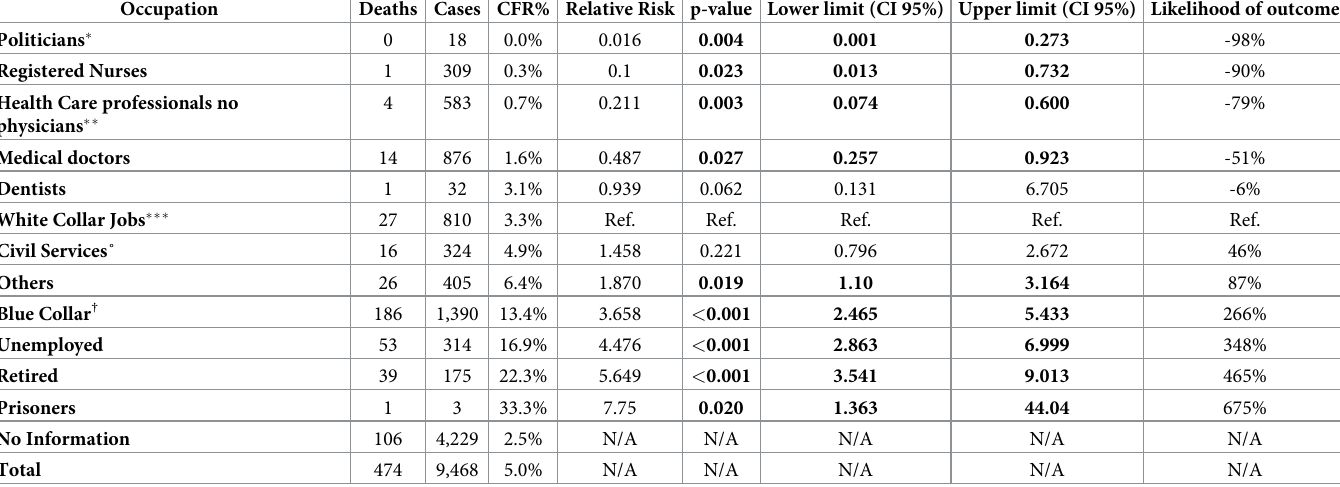
Table 3. Case fatality rate (%), relative risk and risk likelihood due to COVID-19 in Ecuador by occupation. Relative risk was estimated using White-Collar jobs as a reference group. P-values below or equal to 0.05 were considered significant.